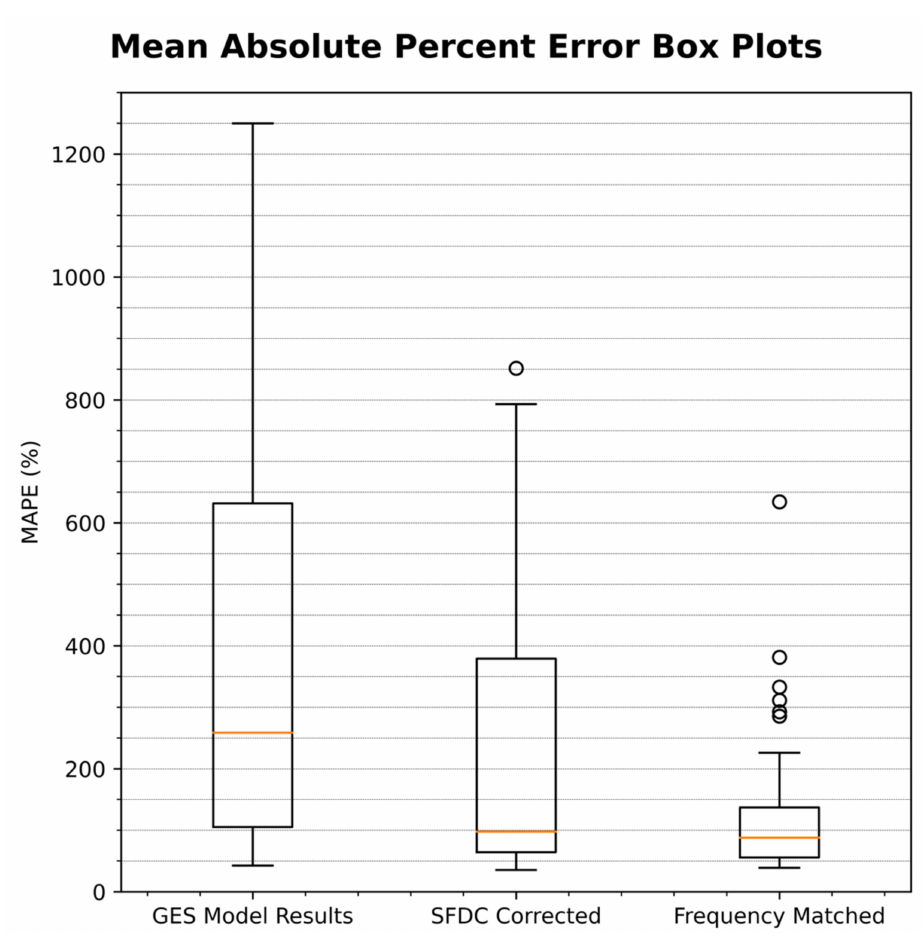
Figure 7. Box plots of MAPE results in the Magdalena River basin for each test